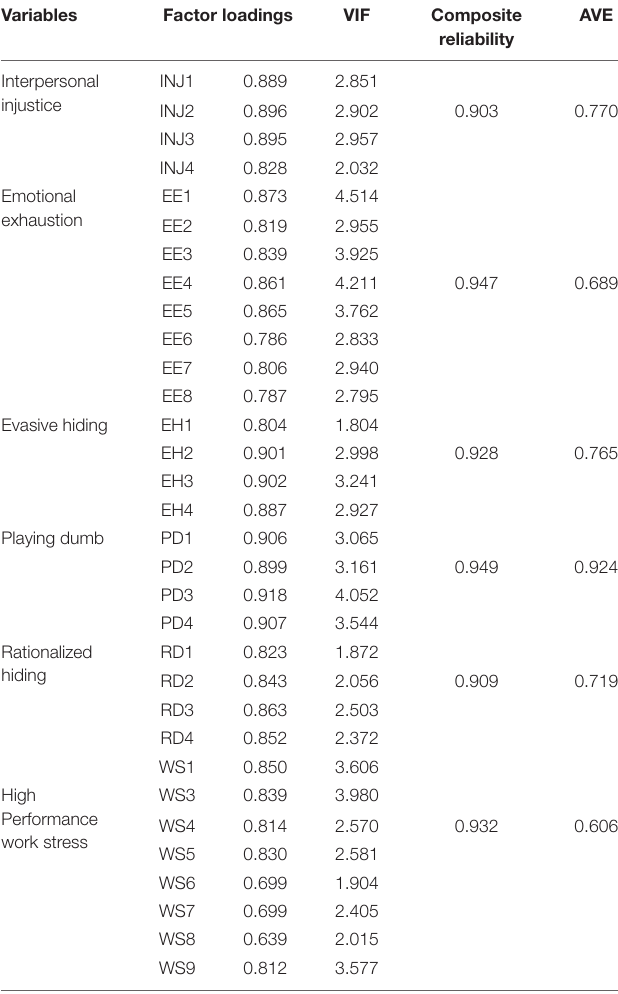
TABLE 9 | Measurement model